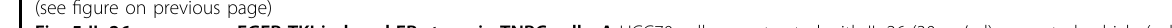
Fig. 5 IL-26 suppresses EGFR-TKI-induced ER stress in TNBC cells. A HCC70 cells were treated with IL-26 (30 ng/ml) or control vehicle (vehi) in the presence or absence of ge fi tinib (40 μ M) for 3 h. Total RNA was isolated and subjected to DNA microarray analysis as described in the “ Materials and methods ” section. Left: A heat map of 943 genes differentially (fold change ≥ 2.0) expressed between ge fi tinib plus IL-26- and ge fi tinib alone- treated HCC70 cells was constructed by hierarchical cluster analysis. Right: signi fi cantly enriched Gene Ontology (GO) terms in ge fi tinib-induced and IL-26-reduced genes. B HCC70 cells were treated with IL-26 (30 ng/ml) in the presence of ge fi tinib (40 µM) for the indicated periods, and then submitted to Western blot analysis using anti-phosphorylated PERK, eIF2 α , and IRE1 antibodies, and reblotting with anti-pan PERK, eIF2 α , and IRE1 antibodies. Data shown are representative of three independent experiments, and similar results were obtained in each experiment. Band intensity of phospho-proteins was normalized to the appropriate pan proteins, and relative intensity compared with unstimulated cells is shown as mean ± SEM from three independent experiments. * p < 0.01. C , D HCC70 cells were treated with IL-26 (30 ng/ml) in the presence or absence of ge fi tinib (40 μ M) for the indicated periods. mRNA expression levels of ATF6 ( C ) or DDIT3, ATF3, and ATF4 ( D ) were quanti fi ed by qRT-PCR. * p < 0.01. E HCC70 cells were treated with IL-26 (30 ng/ml) in the presence or absence of ge fi tinib (40 μ M) for 24 h, followed by immunostaining with anti-human DDIT3 pAb (red), β -tubulin (green), and DAPI (blue). Original magni fi cation, ×400. Scale bar, 20 μ m. F HCC70 cells were treated with IL-26 (30 ng/ml) in the presence or absence of ge fi tinib (40 μ M) for 24 h, followed by JC-1 staining. Red fl uorescence, sign of preserved mitochondrial membrane potential ( ΔΨ m ), was observed in vehicle- or IL-26-treated HCC70 cells in the absence of ge fi tinib, whereas green fl uorescent signals, index of mitochondrial membrane depolarization were prominently observed in vehicle-treated HCC70 cells in the presence of ge fi tinib. Stained cell clusters were quantitated using Image-J software. * p < 0.01. G HCC70 cells were treated with IL-26 (30 ng/ml) and/or ge fi tinib (40 μ M) in the presence of vehicle, signal inhibitors, anti-EphA3 pAb or anti-IL-26 mAb (clone 69-10) (50 µg/ml, each) for 6 h. mRNA expression levels of DDIT3 were quanti fi ed by qRT-PCR. * p < 0.01. H HCC70 cells were treated as described in G for 24 h. Expression of DDIT3 was detected by Immuno fl uorescence staining with anti-human DDIT3 pAb. Fluorescence intensity and stained cell clusters were quantitated using Image-J software. * p < 0.01. C – H Representative data of three independent experiments are shown as mean ± S.D. of triplicate samples, and similar results were obtained in each